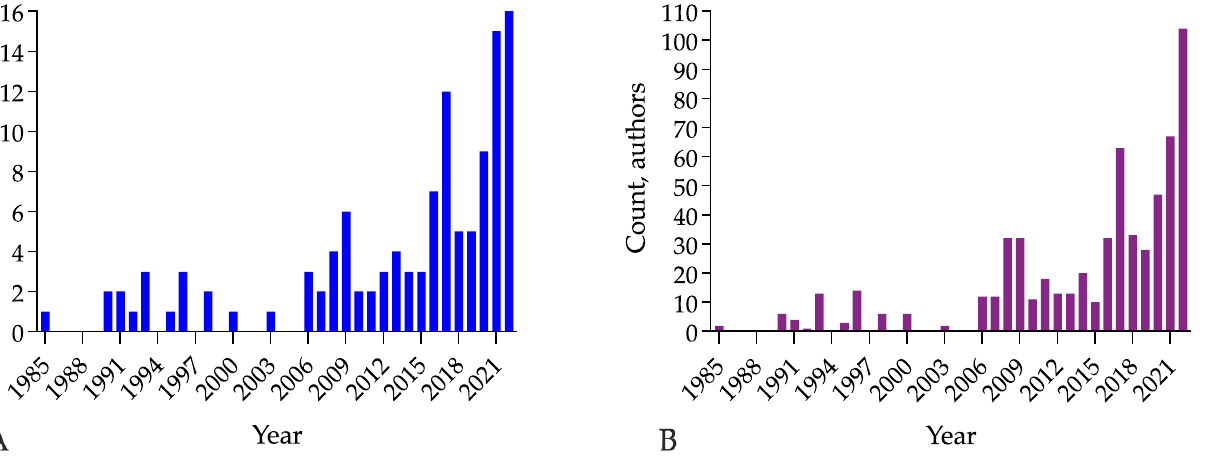
Figure 1. Temporal changes in the number of publications on partial resections of the gallbladder and authors of these articles, from 1985 to 2022. Changes are shown in the number of articles published per year ( A ) and the number of authors by year ( B ). Columns of Figure 1A show the 1600% increase in publications between 1985 ( n = 1) and 2022 ( n = 16). A steady 533% increase in articles has been seen since 2006 ( n = 3); sixteen articles were published in 2022. Columns of Figure 1B show the 5200% increase in the number of authors between 1985 ( n = 2) and 2022 ( n = 104). They also demonstrate an 867% increase in authors writing scientific papers on partial resections of the gallbladder ( n = 12 in 2006, n = 104 in 2022).